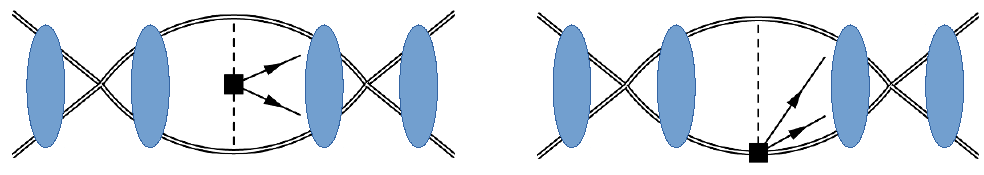
Figure 6 . Examples of ultraviolet divergent contributions to the nn The blue ellipse denotes iterations of the Yukawa potential V (cid:25) , de(cid:12)ned in eq. (B.1). where the position-space tensor is de(cid:12)ned by S ( mn ) (^ r ) =